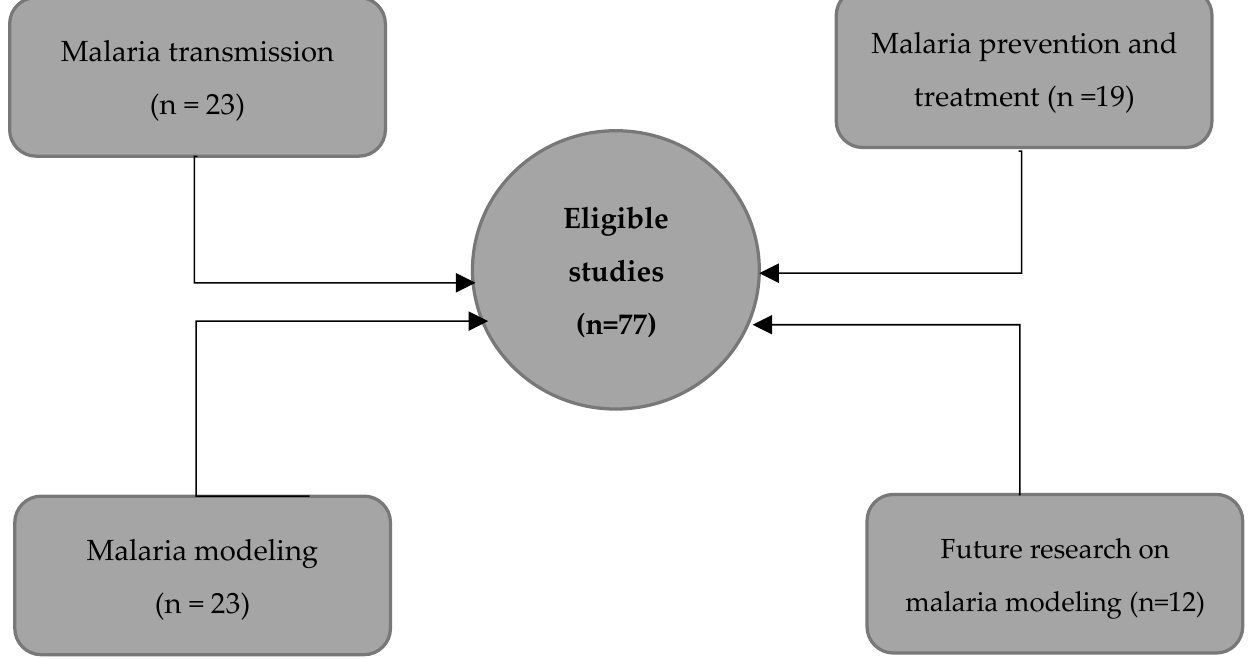
Figure 2. Overview of the thematic distribution of the selected